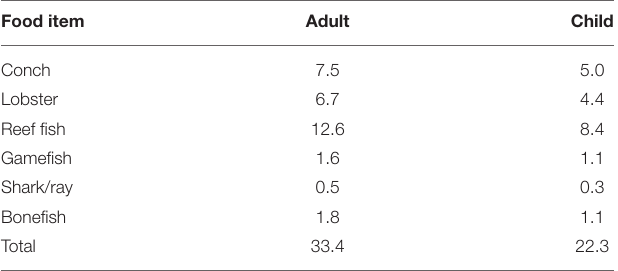
TABLE 1 | Per capita national seafood consumption rate in the Turks and Caicos Islands, 2013 (kg · year − 1 ). Food item